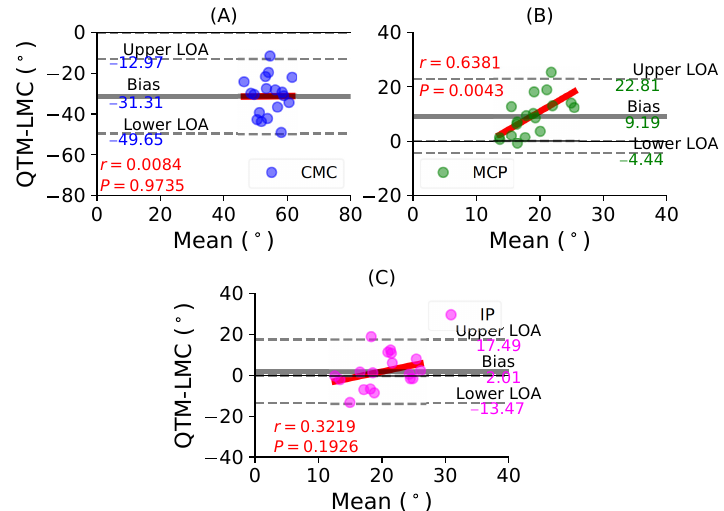
Figure 6. A BA plot of thumb flexion. ( A ) CMC joint, ( B ) MCP joint and ( C ) IP joint. Figure 7A shows a BA plot for the MCP joint with a negative bias of 1.25 ◦ with r = − 0.3963, P = 0.1152. Figure 7B shows a negative bias of 1.1 ◦ with r = − 0.1062, P = 0.6894 for the PIP joint. Lastly, Figure 7C shows a positive bias of 0.1 ◦ with r = − 0.0384, P = 0.8835 for the DIP joint. During the index finger flexion movement, none of the joints demonstrated a positive correlation between the two measurement systems.